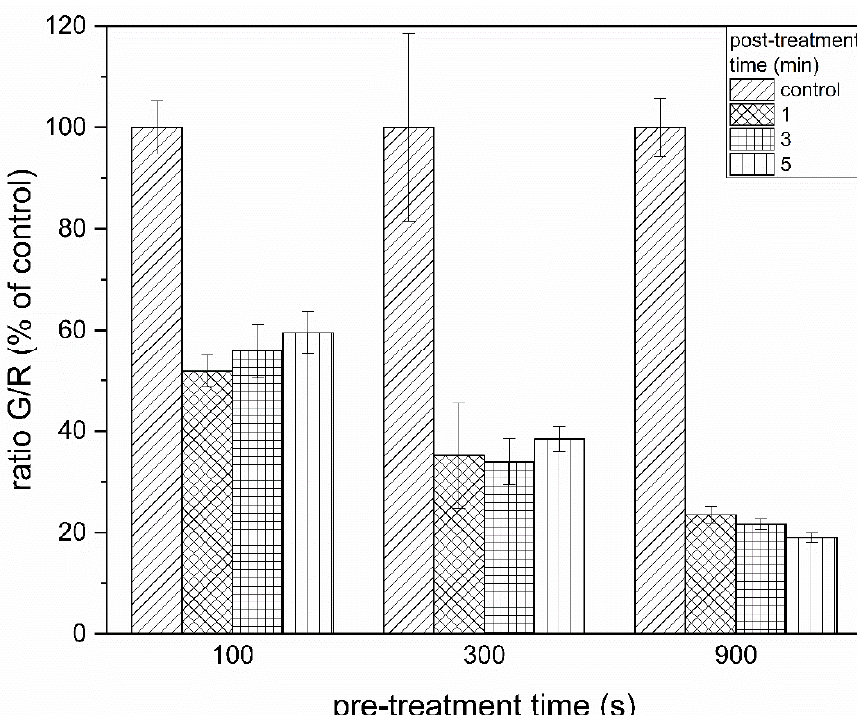
Figure 2. The graph shows the reduction in the ratio G/R after treatment of the biofilms with the PTW. The grouped bar chart show at the x-axis the water treatment time with the Midiplexc (pretreatment time) and the different bars show the biofilm treatment time with the PTW (post-treatment time). The experiment was performed in four independent experiments with three technical replicates each.